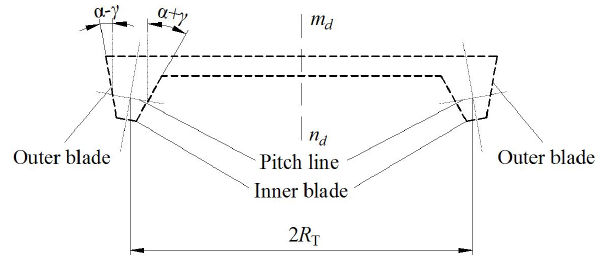
Figure 3. Gear cutter-inclined large milling cutter.